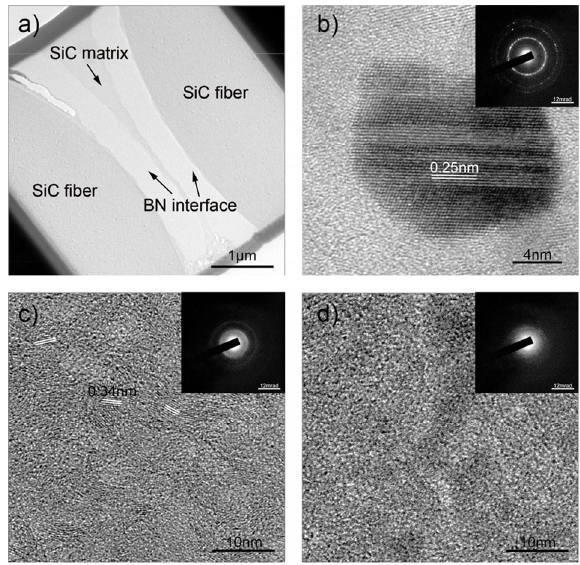
TEM images and SAED patterns for each constituent of the KD-S SiC f /SiC composites with BN interface layer: (a) bright field TEM image taken on the cross-sectional specimen, (b) SiC fiber, (c) BN interface, and (d) SiC